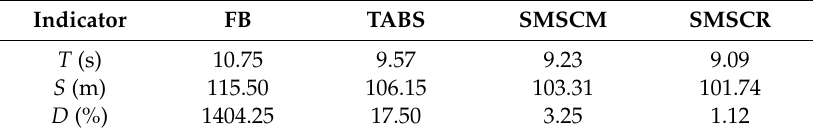
Figure 7. Simulation results of four emergency braking control strategies mentioned in Section 4.1 on snow. They are the curves of vehicle and track speed, slip ratio, and braking torque of: ( a ) FB; ( b ) TABS; ( c ) SMSCM; ( d ) SMSCR. Table 3. The value of indicators in the simulations on snow.